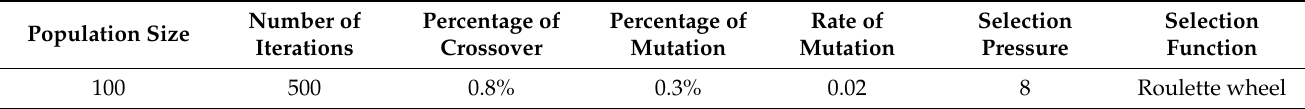
Table 5. Tuning parameters used for the ANFIS-GA